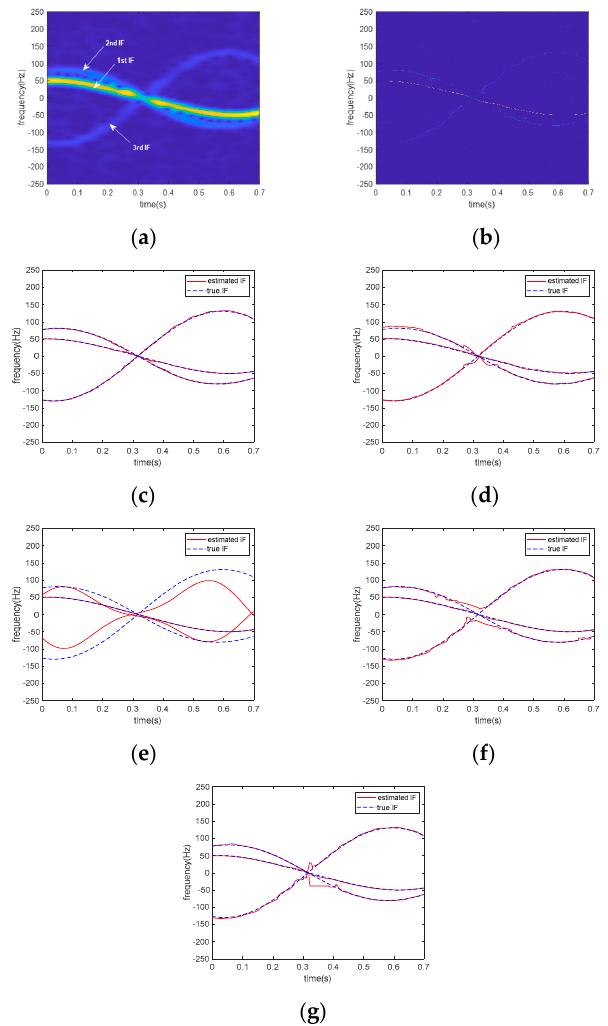
Figure 10. TF spectrums and IF estimation results for example 4 with SNR = 20 dB. ( a ) TF representation acquired by STFT; ( b ) TF representation acquired by SET. ( c ) MKF; ( d ) MTT; ( e ) CSRDI-MGPTF; ( f ) MD-STFT; ( g ) MD-SET.